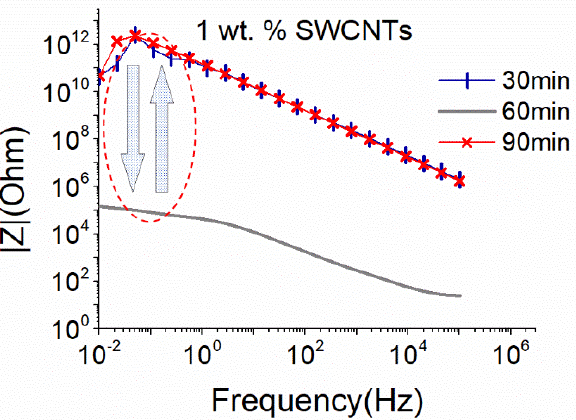
Figure 4. EIS plots of aqueous dispersion with 1 wt.% SWCNTs, using the big sonication probe at an amplitude of 25% (18.6 W).